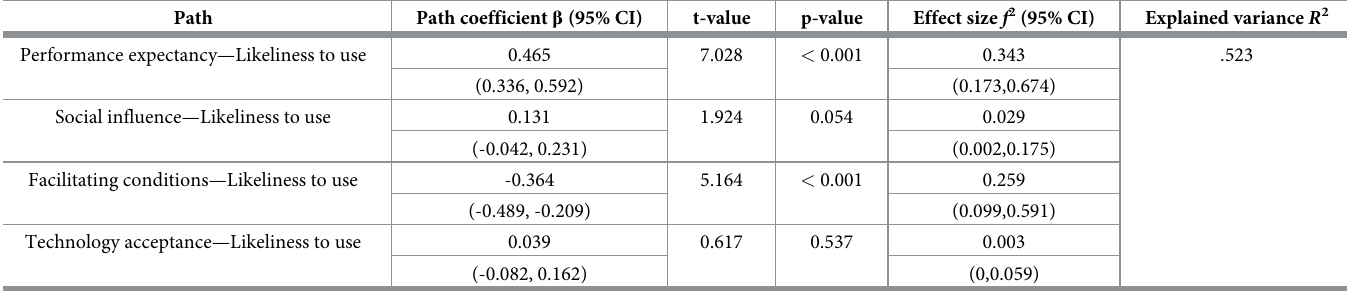
Table 5. Path coefficients between the independent and dependent construct variables. Also included are the t-value, p-value, effect size, and the dependent construct variables explained variance.